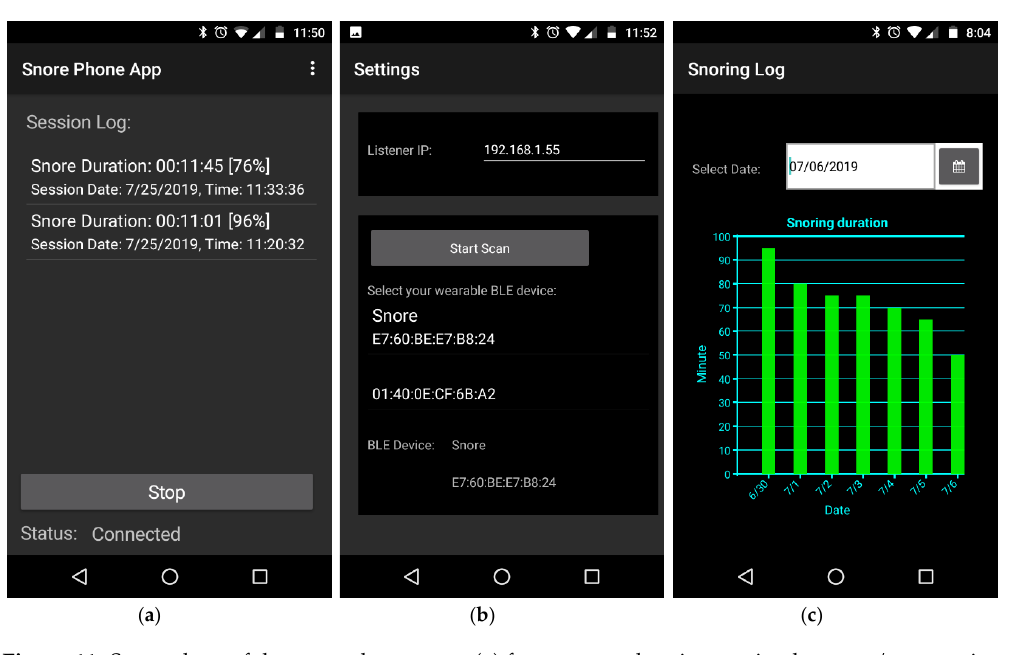
Figure 11. Screenshots of the smartphone app – ( a ) front screen showing session log, start/stop session button and connection status with listener module; ( b ) setting screen for configuring listener module’s IP and wearable gadgets BLE MAC address; ( c ) bar graph of snoring duration on last seven days of the selected date.